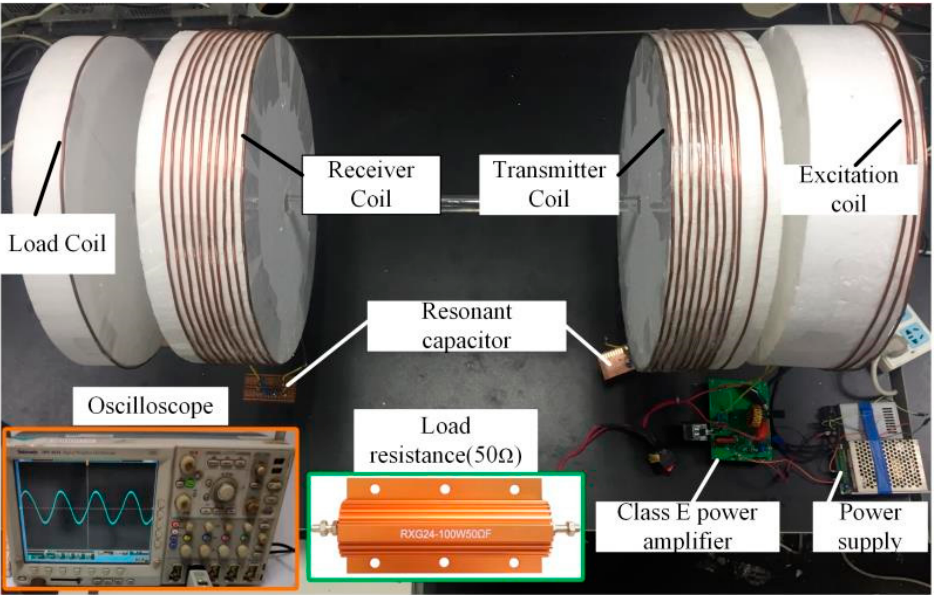
Figure 12. Experimental set up.